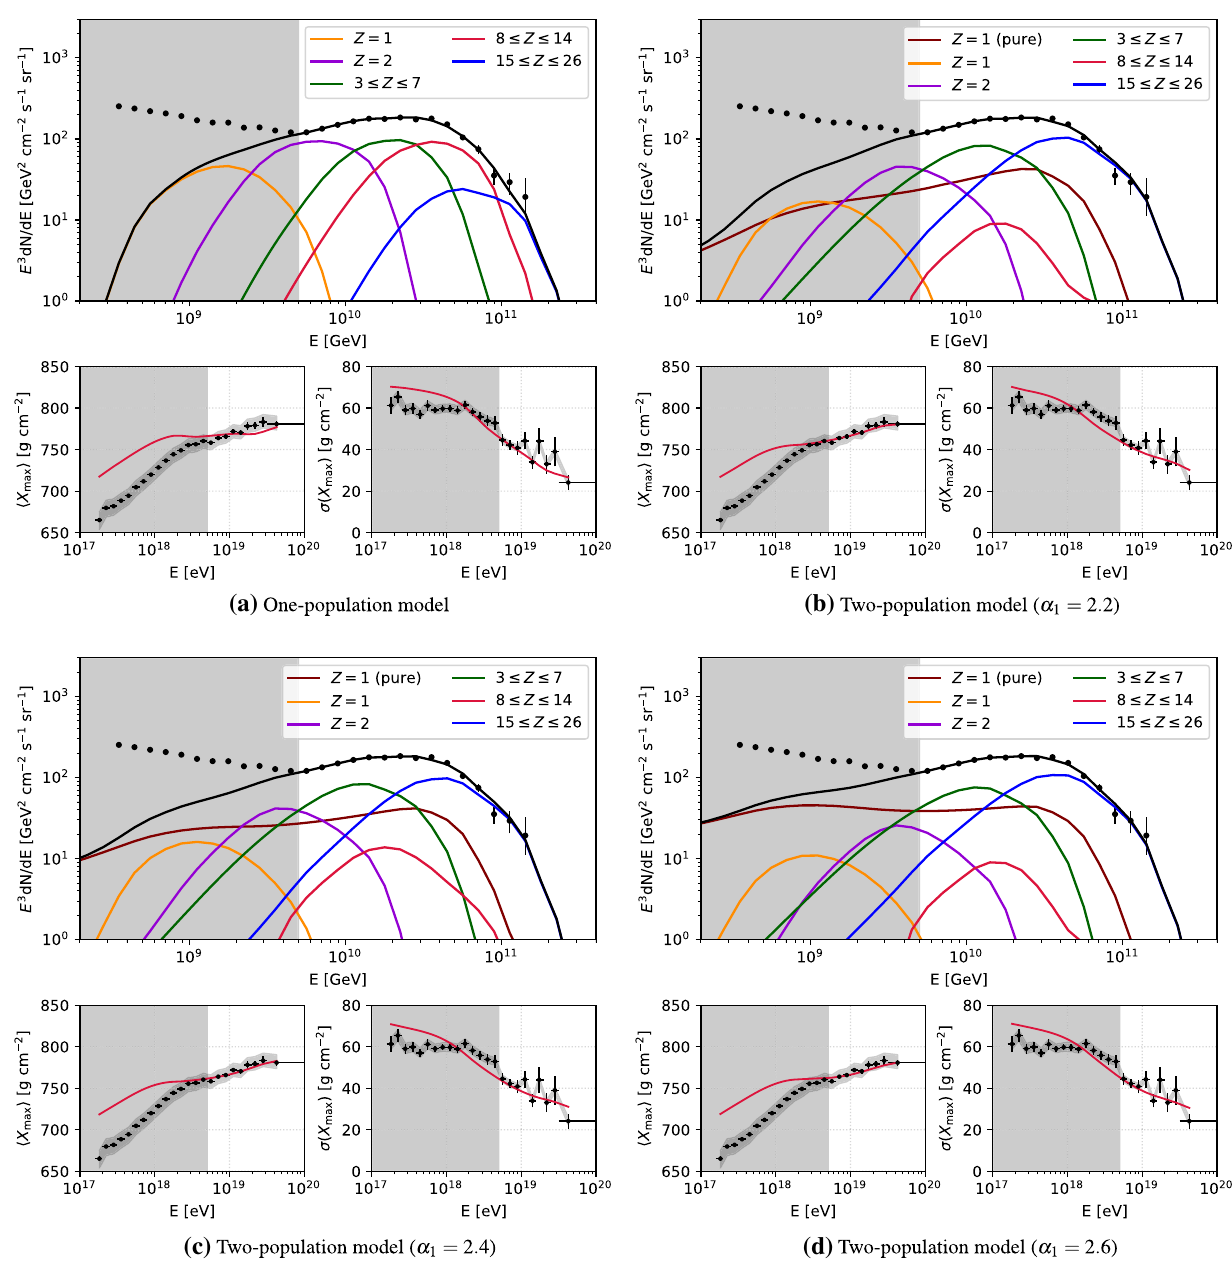
Fig. 1 UHECR spectrum and composition for the best-fit parameters of single-population and two-population models in the flat ( m = 0) cosmo- logical evolution scenario. For the latter case, the resulting spectra for different injection spectral index of the pure-proton component are shown